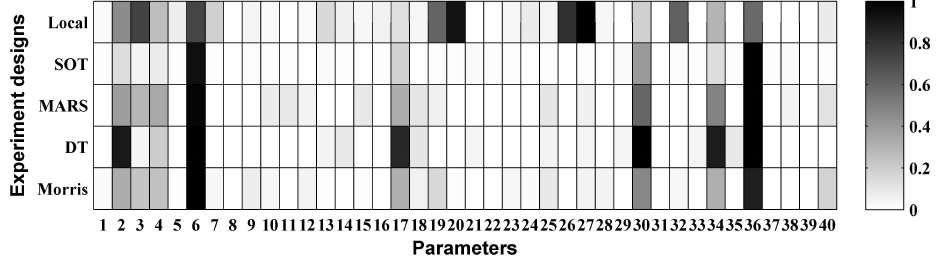
Fig. 6. The qualitative sensitivity analysis results of different methods for sensible heat. The sensitivity scores are normalized to [0, 1]; 1 means most sensitive and 0 means least sensitive.